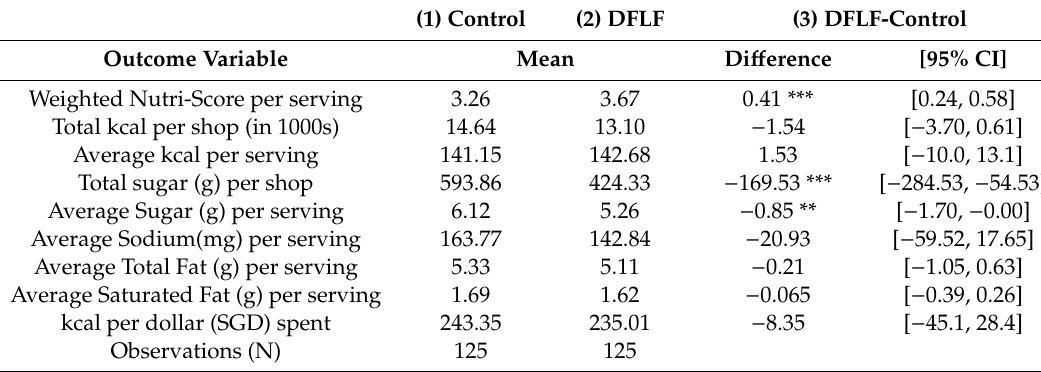
Table 2. The e ff ects of the dynamic food labels with real-time feedback (DFLF) on the nutritional quality of purchased foods and